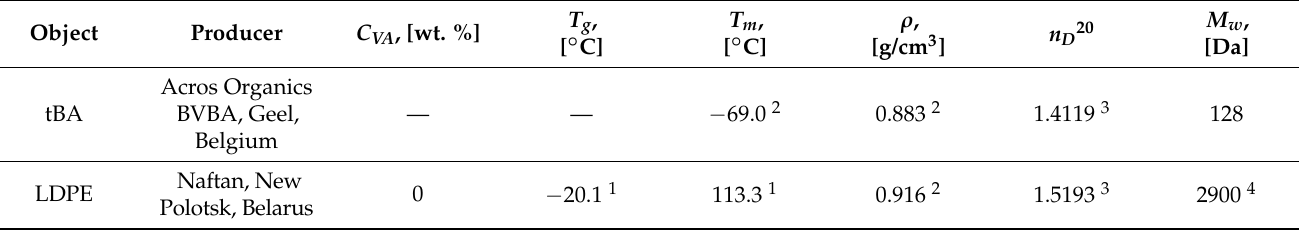
Table 1. Properties of the research